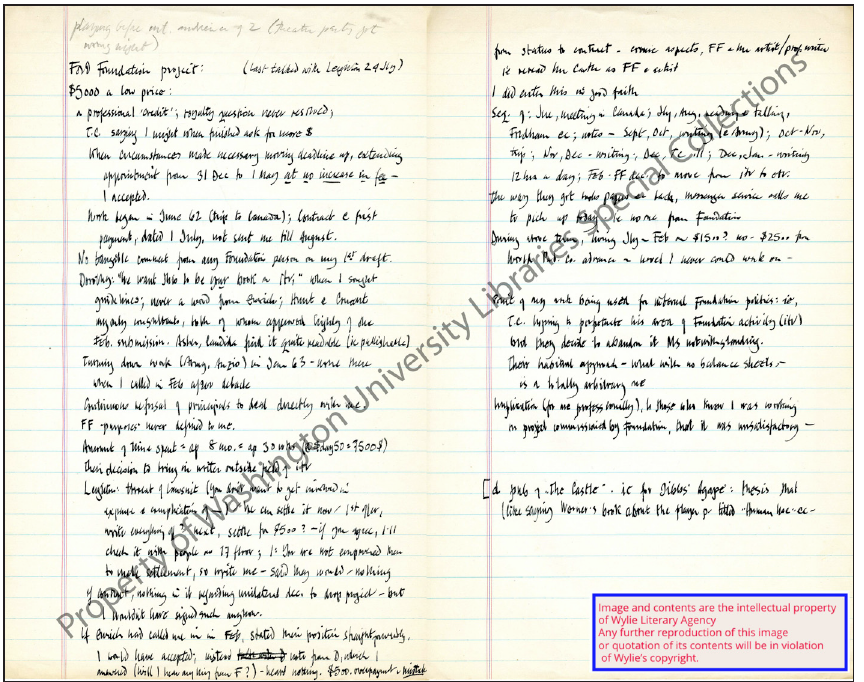
Figure 2: Gaddis’ Account of the Ford Project’s